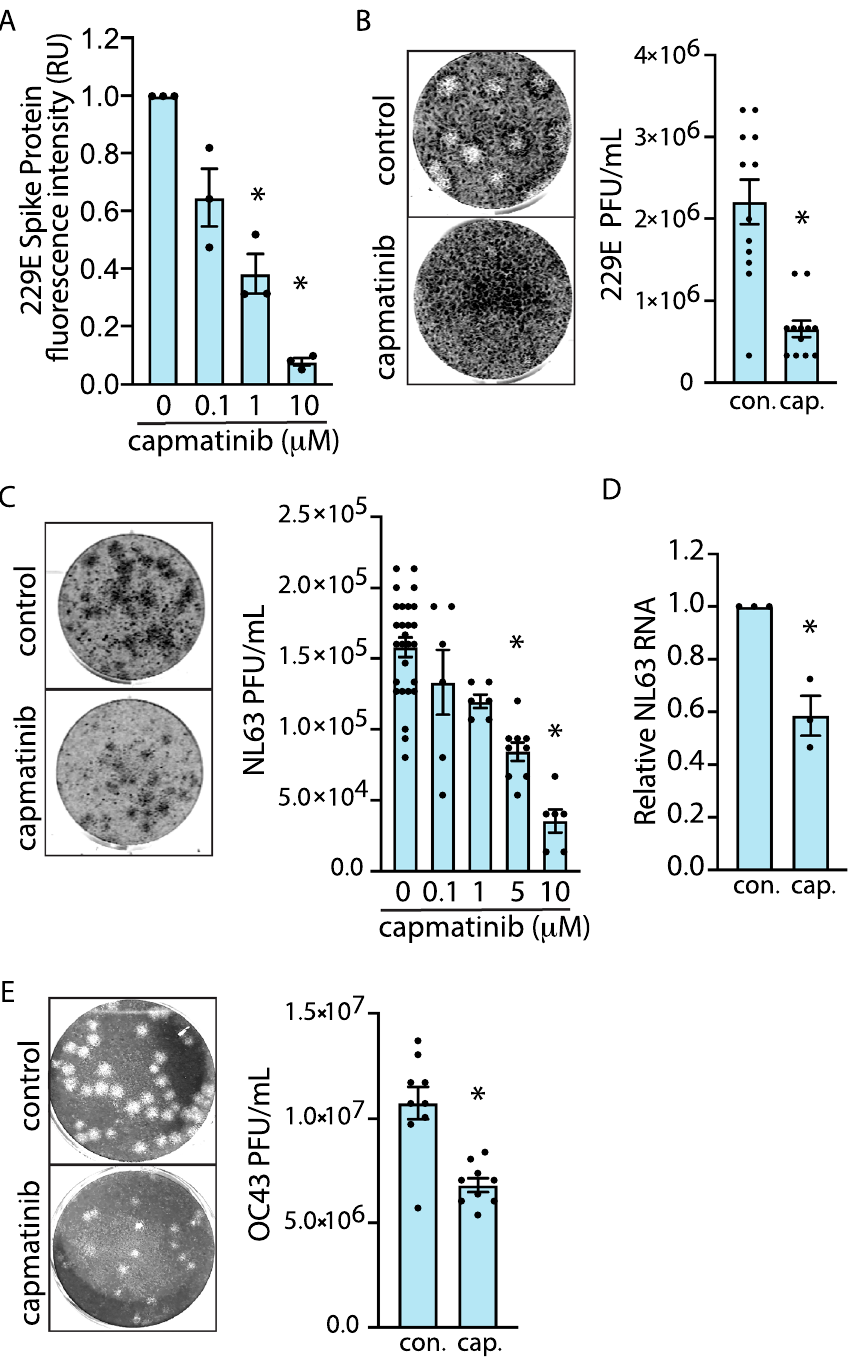
Figure 3. Capmatinib has a broad range of antiviral activity against human coronaviruses. ( A ) Quantification of 229E Spike protein abundance in MRC-5 cells treated with increasing doses of capmatinib in the IF assay (48 h infection), as mean ± SE (n = 3) expressed relative to DMSO (vehicle) control. * P < 0.05 relative to control ( B ) (left) Representative images of 229E plaques observed in MRC-5 cells treated with 10 µM capmatinib or DMSO (vehicle) for 6 days. (right) Quantification of viral titer from the DMSO (vehicle) control or capmatinib plaque assays, expressed as PFU/mL. * P < 0.05 relative to control ( C ). (left) Representative images of NL63 plaques observed in LLC-MK2 treated with 10 µM capmatinib or DMSO (vehicle) control for 5 days. (right) Quantification of NL63 PFU/mL in LLC-MK2 cells treated with the indicated doses of capmatinib. * P < 0.05 relative to control ( D ). Relative NL63 N protein RNA abundance 3 days post-infection in LLC-MK2 cells treated with 10 µM capmatinib relative to DMSO (vehicle) control. * P < 0.05 relative to control, n = 3 experimental replicates. E (left) Representative images of OC43 plaques observed in LLC-MK2 cells treated with 10 µM capmatinib or DMSO (vehicle) for 5 days. (right) Quantification of OC43 PFU/mL in LLC-MK2 cells treated with capmatinib or DMSO (vehicle) control. * P < 0.05 relative to